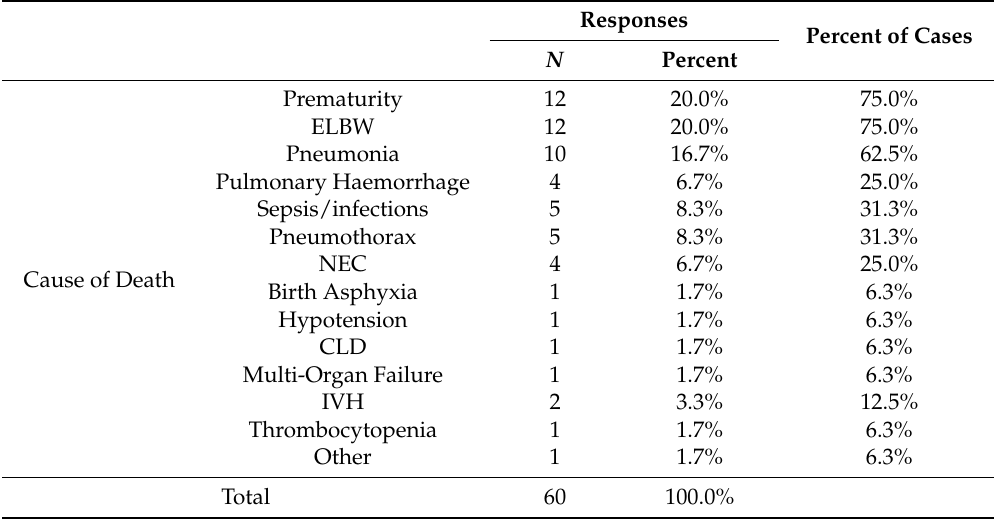
Table 2. Major causes of death in children who died.